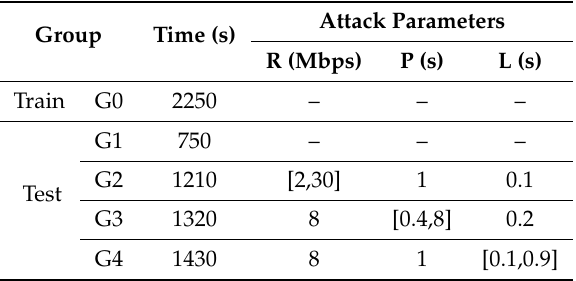
Table 1. Experimental parameters of NS2.